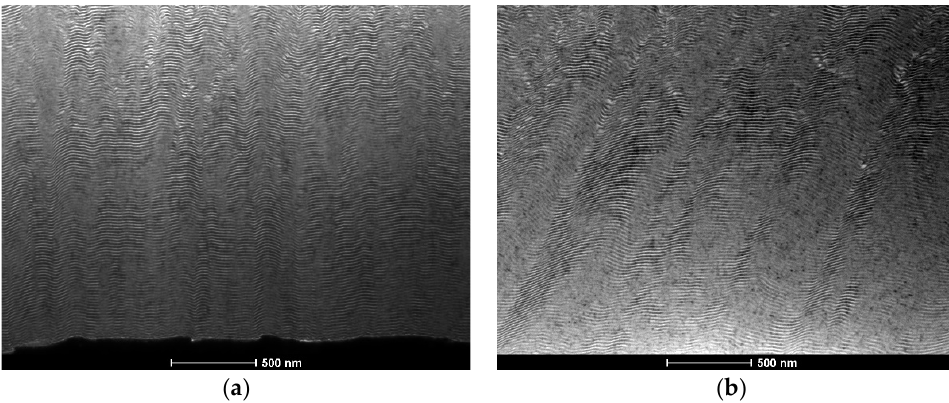
Figure 6. BF TEM cross-section micrographs of an Al/Ni thin film with Λ ≈ 20 nm, deposited using the new substrate holder (Figure 1). ( a ) bottom, and ( b ) top of the W wire ( φ = 0.20 mm).